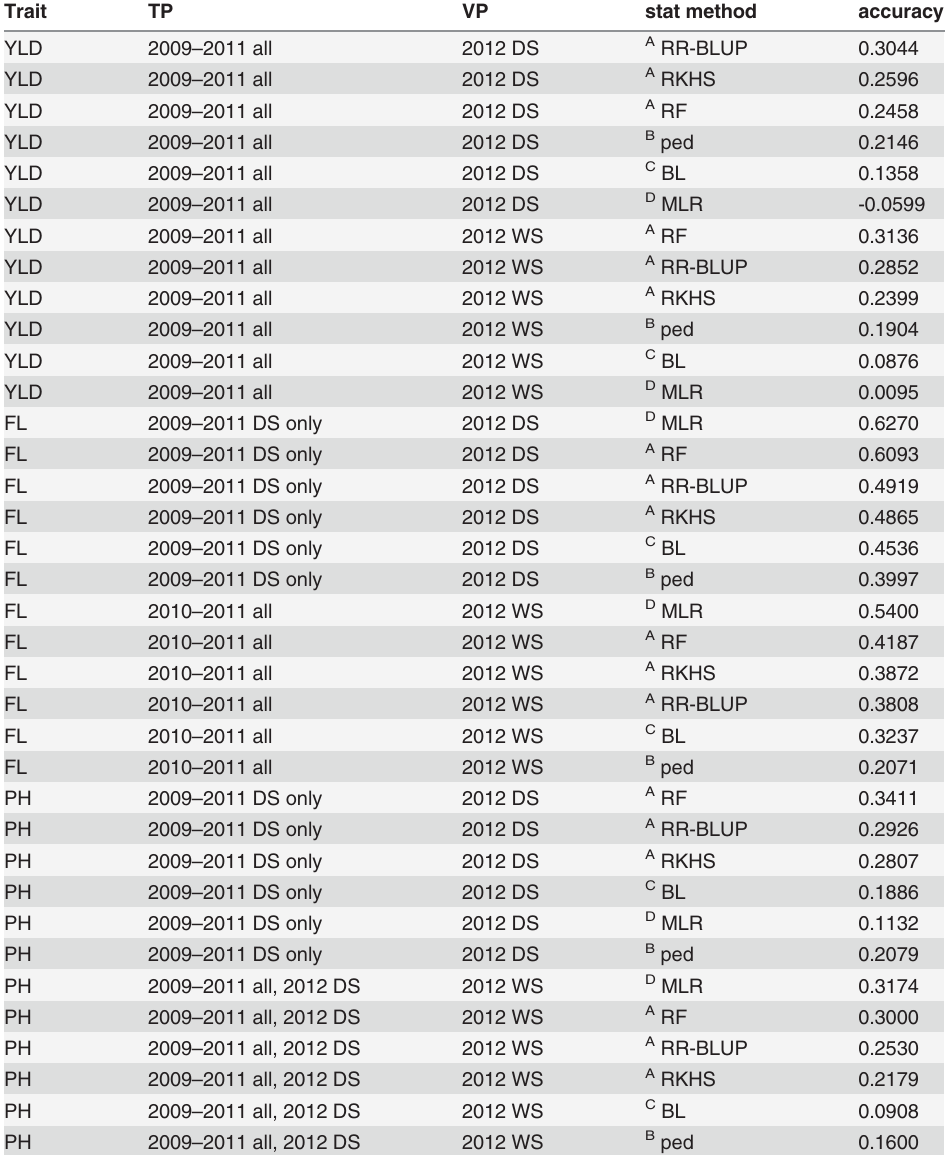
Table 2. Summary of best performing GS experiments for predicting grain yield (YLD), fl owering time (FL), and plant height (PH) in the 2012 dry season (2012 DS) and the 2012 WS (2012 WS) Trait TP